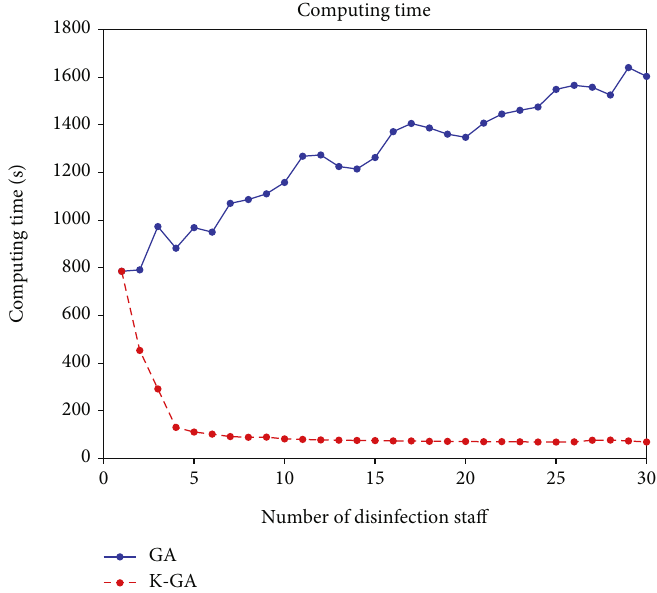
Figure 4: Relationship between the number of sta ff and the computing